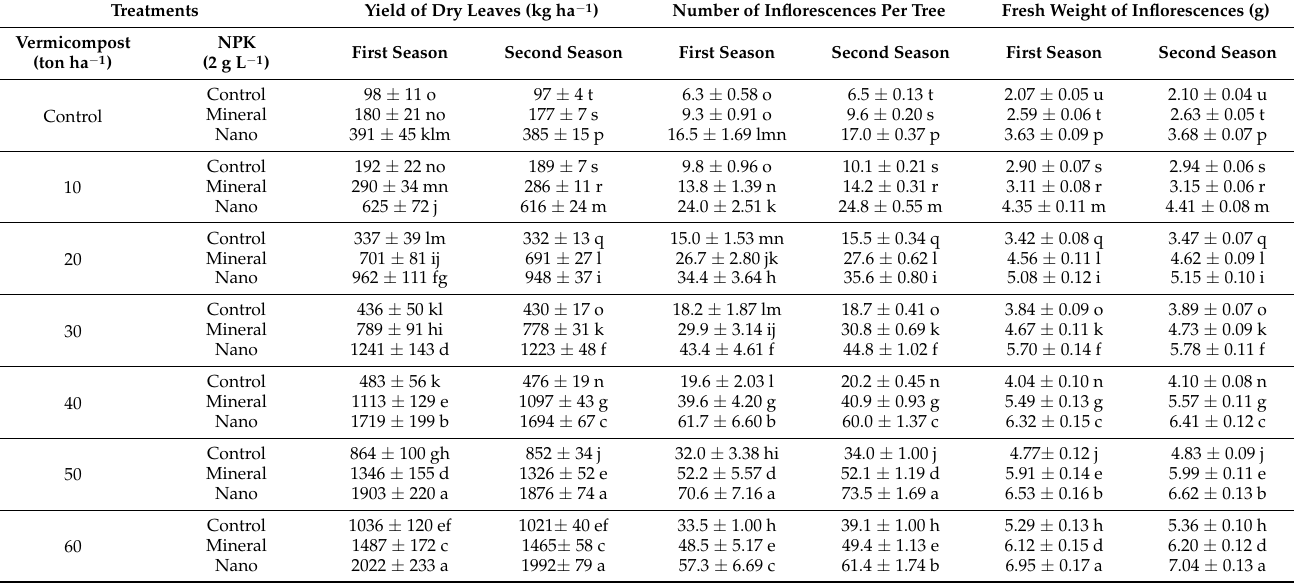
Table 4. The influence of combined treatments of vermicompost and NPK fertilization on the mean values of yield of dry leaves (kg ha − 1 ), number of inflorescences per tree, fresh weight of inflorescences (g) of Moringa oleifera trees in the first and second